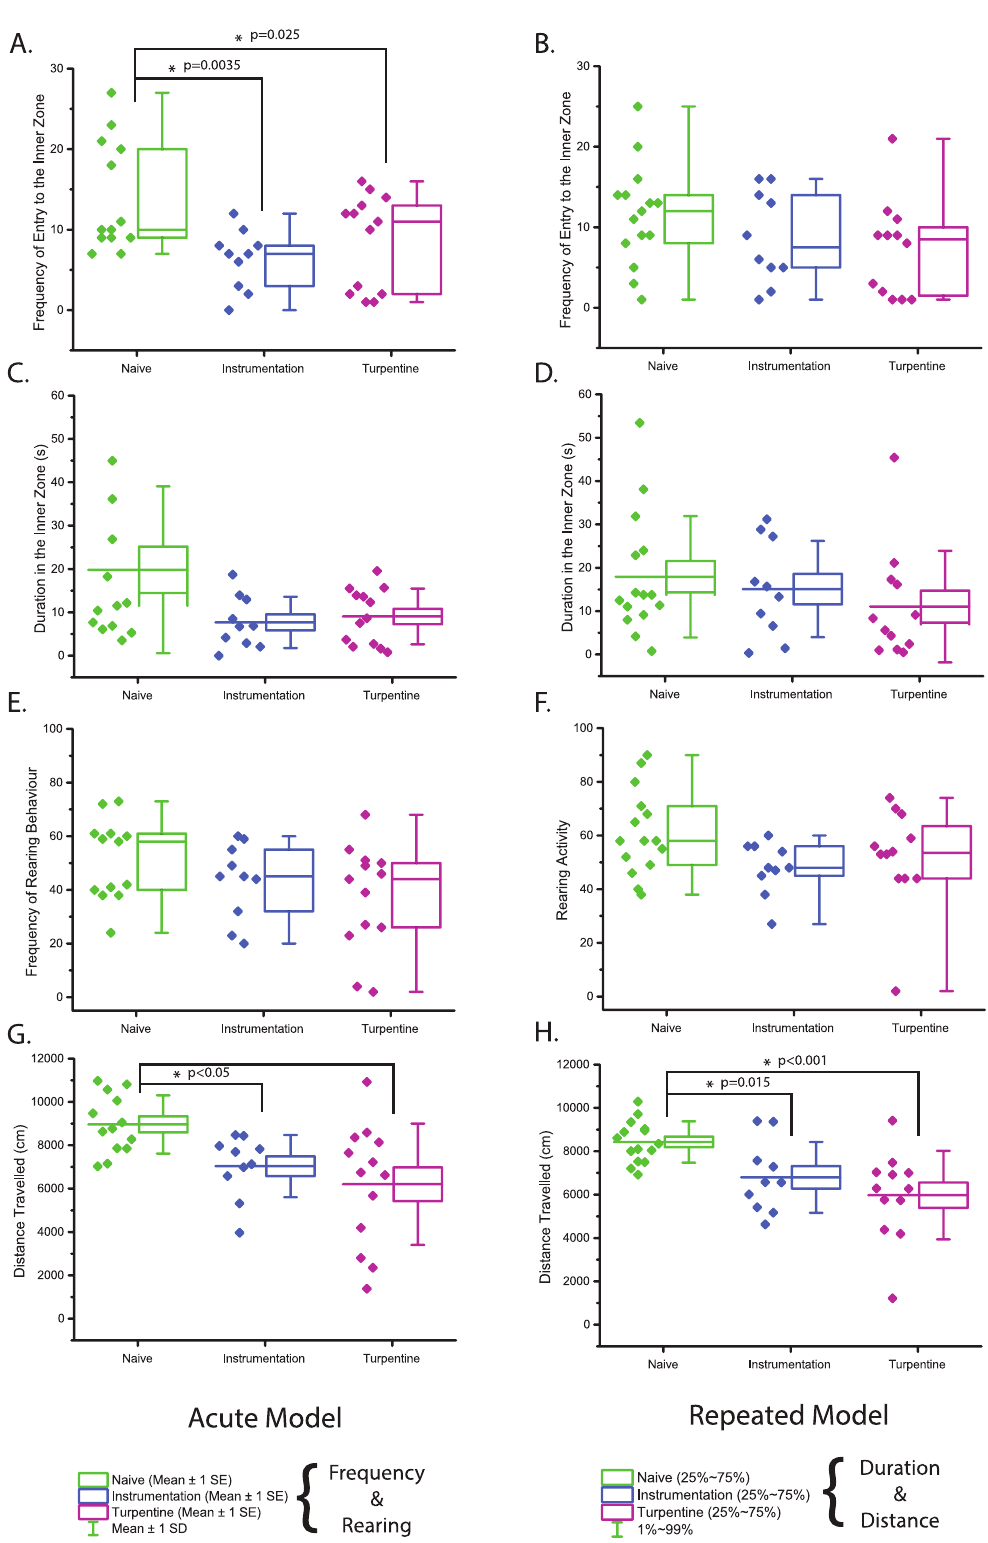
Figure 3. Open field behaviour 24hrs after acute (A , C , E , G; n=9–13) or repeated (B , D , F , H; 10–16) bladder inflammation. A / E - Frequency of entry to the inner zone, B / F - duration in the inner zone (s) , C / G - rearing frequency, D / H - total distance travelled (cm)